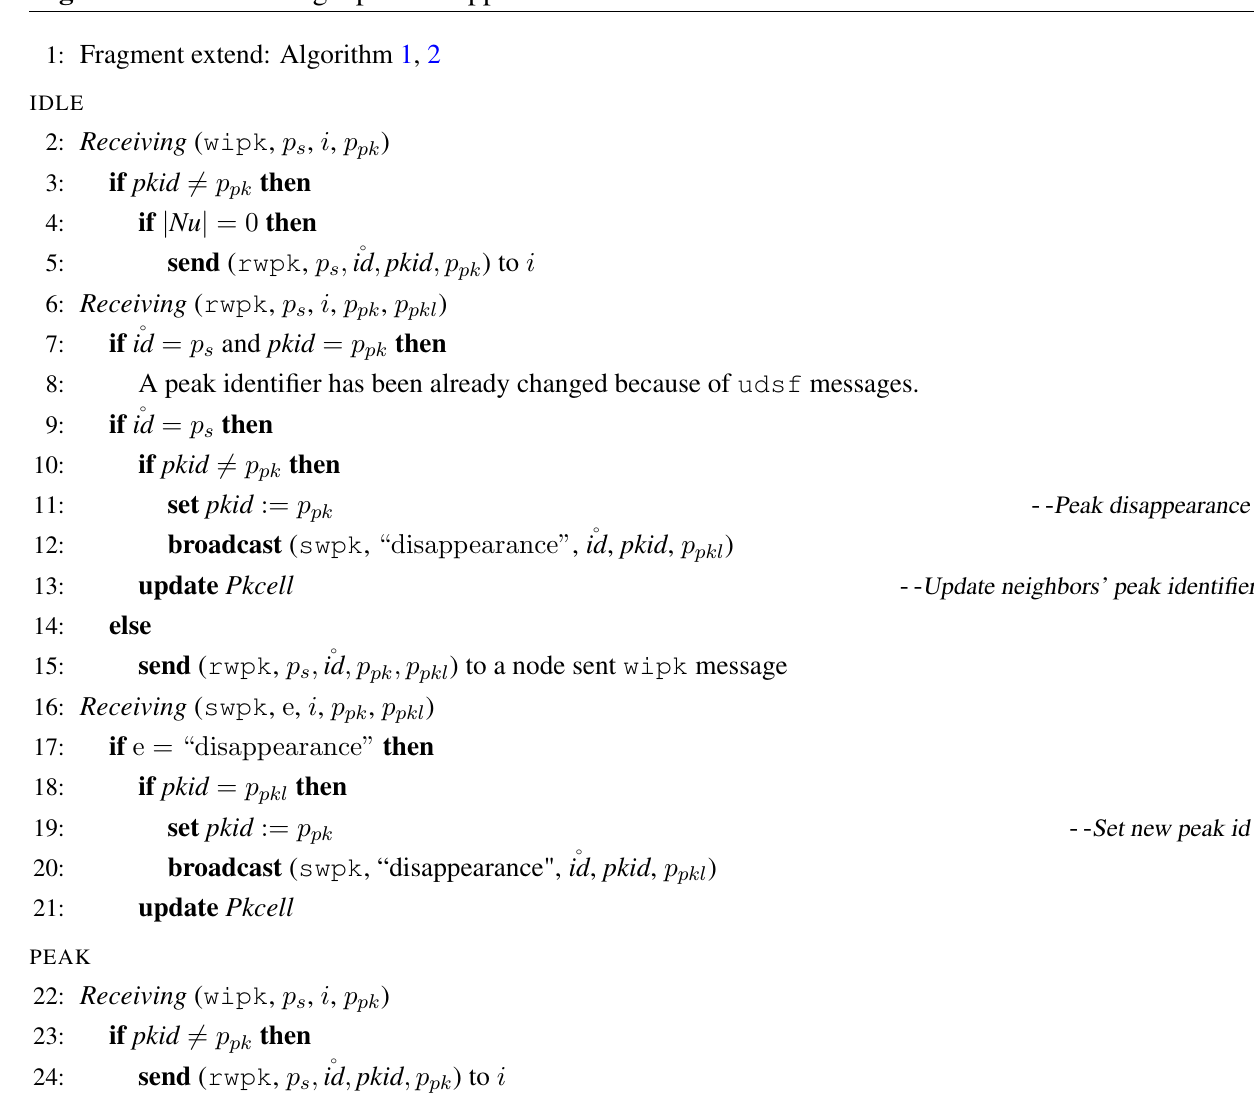
Algorithm 3 Monitoring a peak